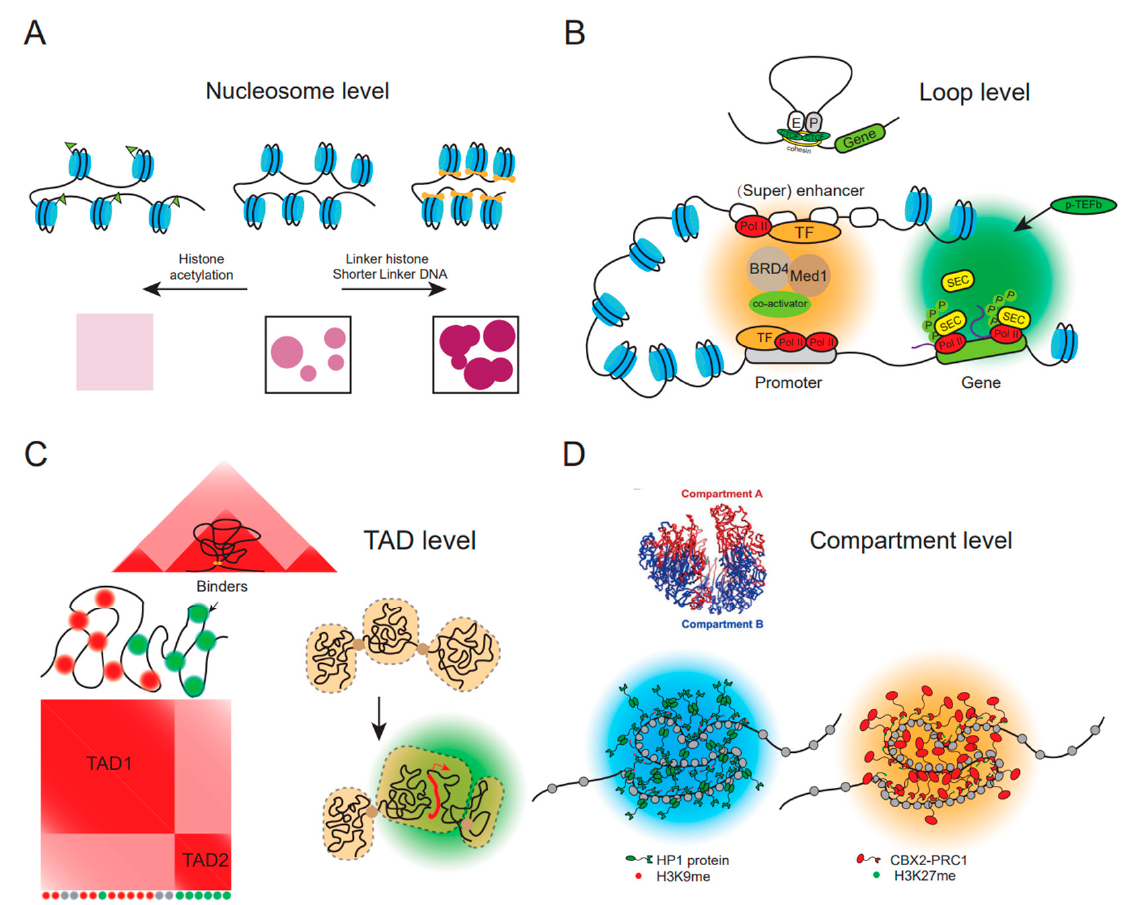
Figure 1. Phase separation contributes to chromatin organization at different levels. ( A ) At nucleosome level, nucleosomes intrinsically condensate chromatin into globules. Linker DNA length, histone H1 and histone modification can dissolve or alter the property of separated phase. ( B ) At chromatin loop level, phase-separated transcriptional condensates are established composing of transcription factors, mediator, co-activator and Pol II, which are important for gene expression. Phosphorylation of the Pol II C-terminal domain drives an exchange from condensates that are involved in transcription initiation to those that are involved in RNA processing. ( C ) At TAD level, TADs can be recreated in computational polymer models by assuming intra-polymer self-interactions. In addition, phase separation controls TAD reorganization to promote specific gene expression and cell fate transitions. ( D ) At compartment level, phase separation contributes to formation of both constitutive and facultative heterochromatin. For constitutive heterochromatin, HP1 recognize and bind H3K9me to trigger the formation of separated aggregates. For facultative heterochromatin, phase separation is driven by CBX2-PRC1 and